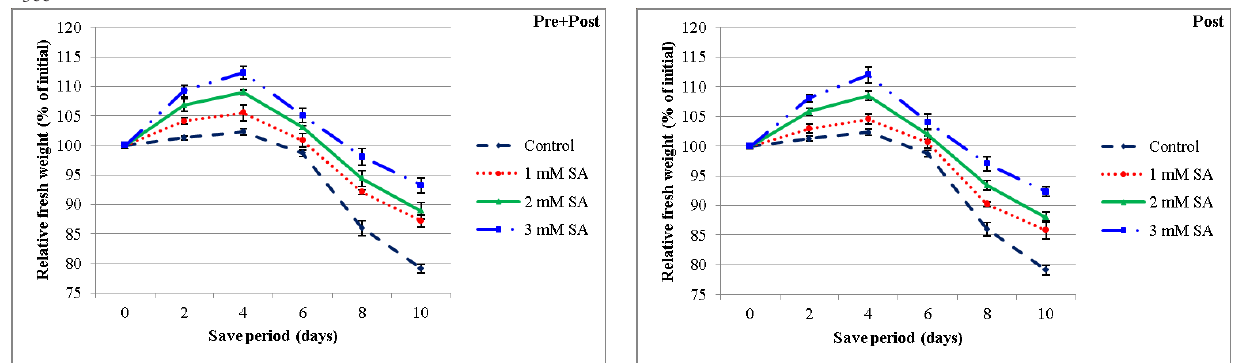
Fig. 1. Effect of pre + post-harvest and post-harvest applications of different concentrations of salicylic acid on relative fresh weight (% of initial) of cut alstroemeria flowers during vase period. The results represent the means of 12 cut flowers in 4 replicates ± stan- dard errors